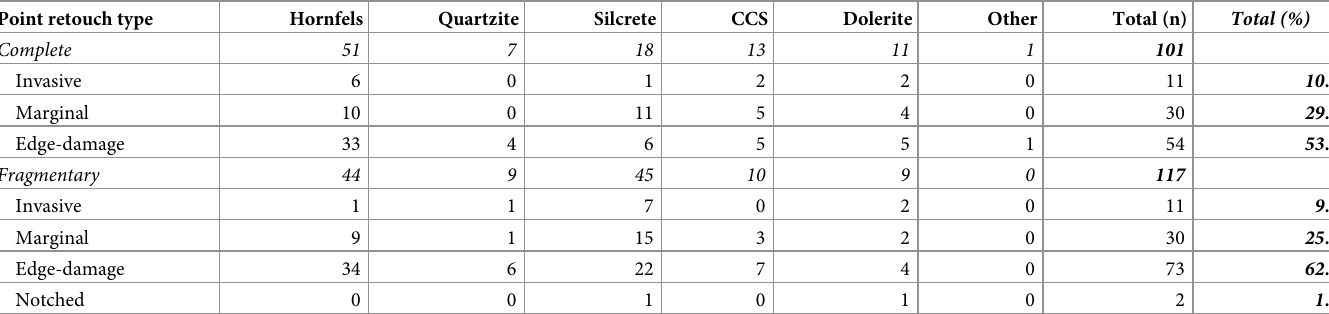
Table 11. Frequencies of retouch type for complete and fragmentary points by raw material.